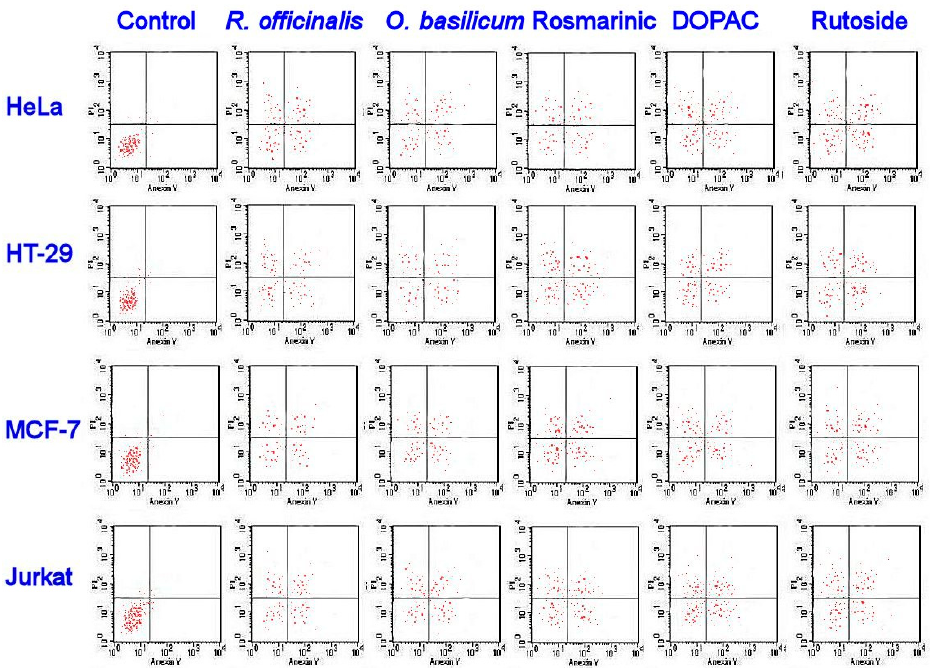
Figure 2. Cytotoxicity of R. officinalis and O. basilicum leaf extracts, and rosmarinic acid, 3,4-dihydroxyphenylacetic acid (DOPAC), and rutoside, as estimated with flow cytometry. There was an accumulation of apoptotic cells in the early (lower right quadrant) and late apoptotic (upper right quadrant).